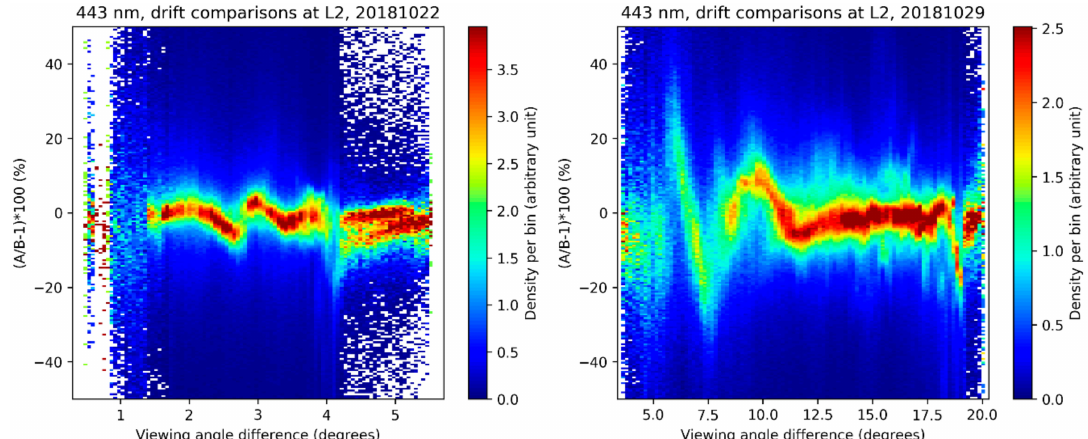
Figure 19. Relative di ff erences of OLCI-A and OLCI-B water-leaving reflectance at 443 nm as function of the viewing angle di ff erence for the two drift dates available in the archive ( left : 22nd October, 3 min apart; right : 29th October, 9 min apart). Density histograms are made per viewing angle